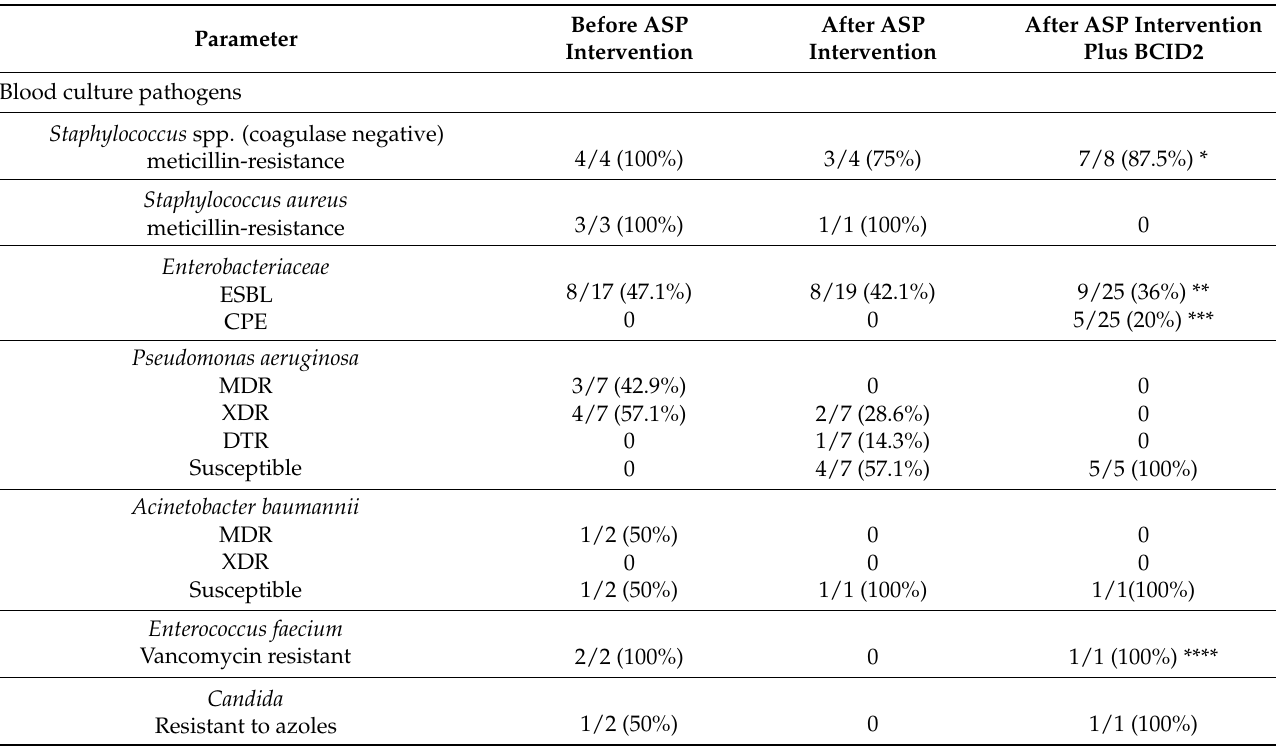
Table 4. Antibiotic resistance profiles of bacterial and fungal bloodstream infections. Before ASP After ASP Parameter Intervention